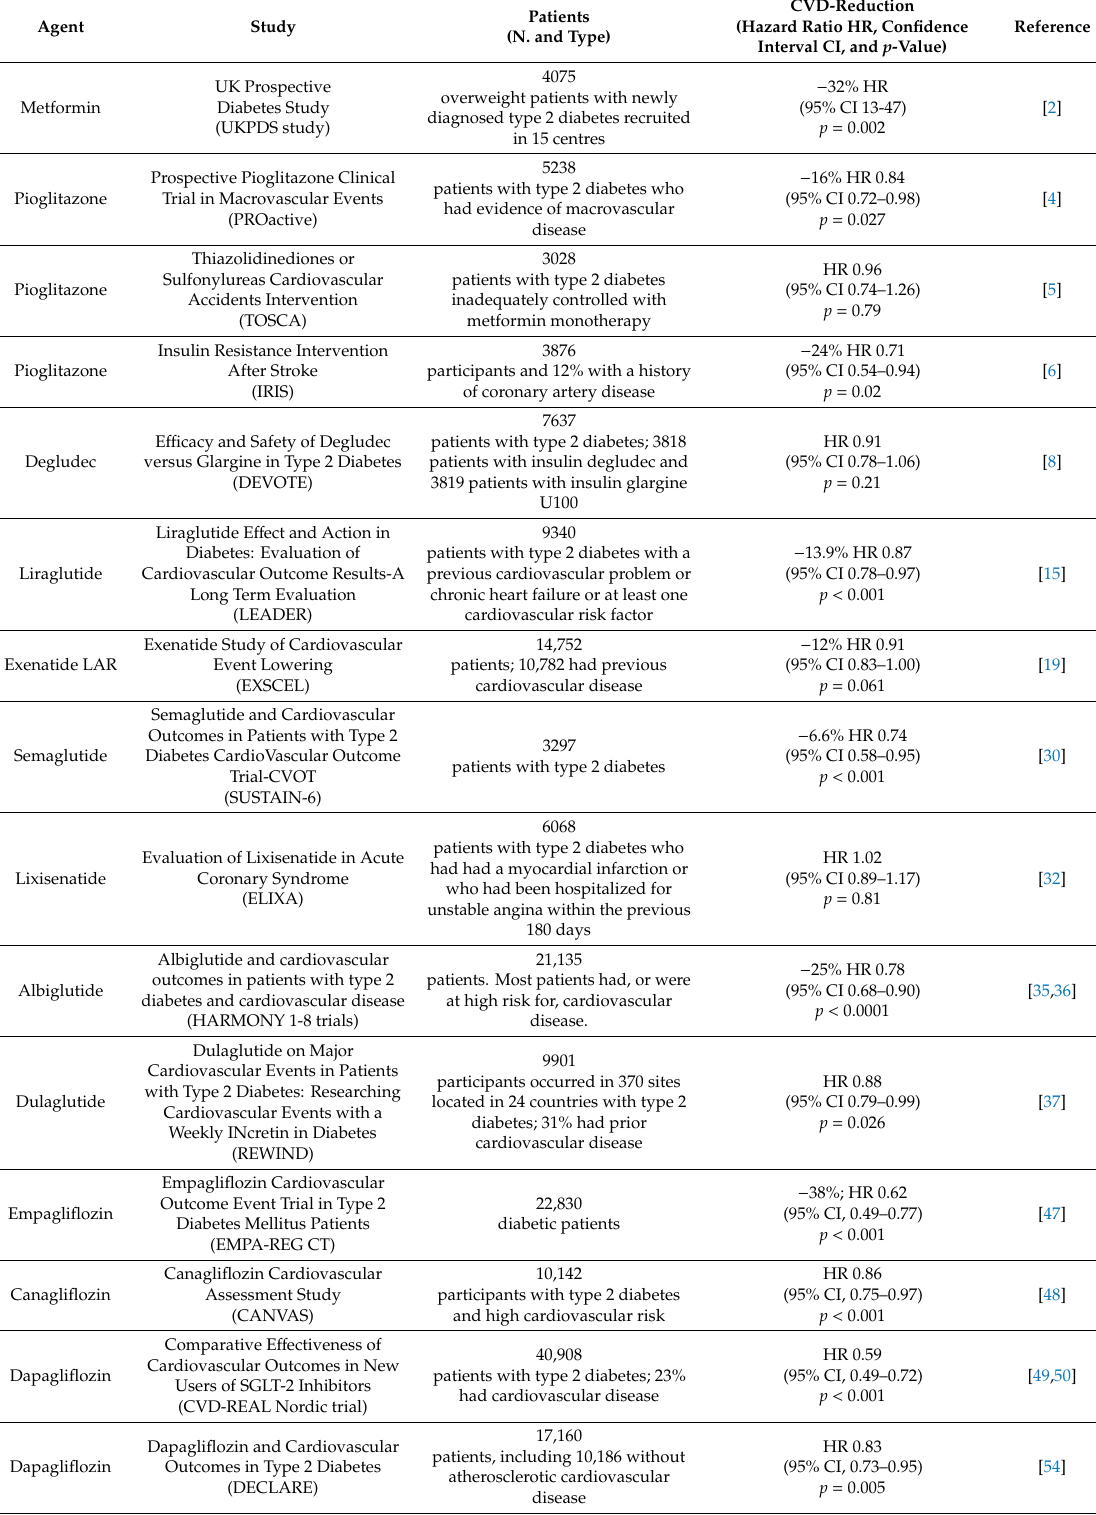
Table 2. Hypoglycemic drugs and cardiovascular disease (CVD)-reduction: An overview of CVOTs. Agent Study